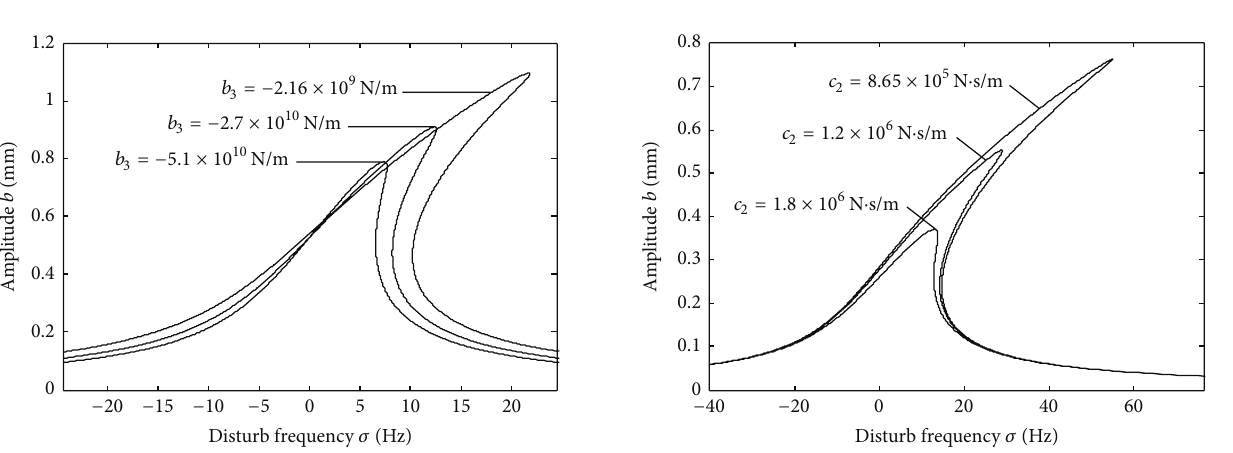
Figure 5: Main resonance amplitude frequency curve of different structural damping 𝑐 2 .